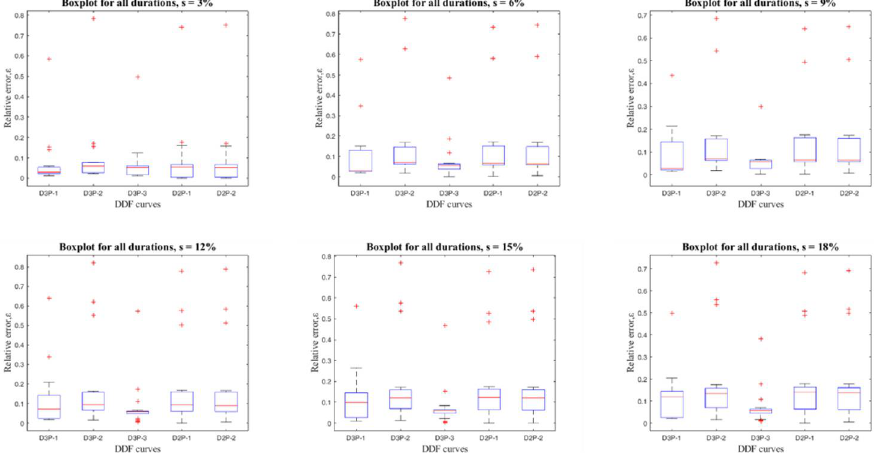
Figure 12. Boxplot on peak discharge.